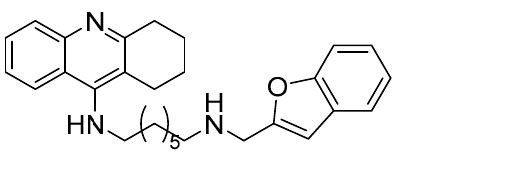
Figure 6. The most active tacrine–benzofuran hybrid from [126].